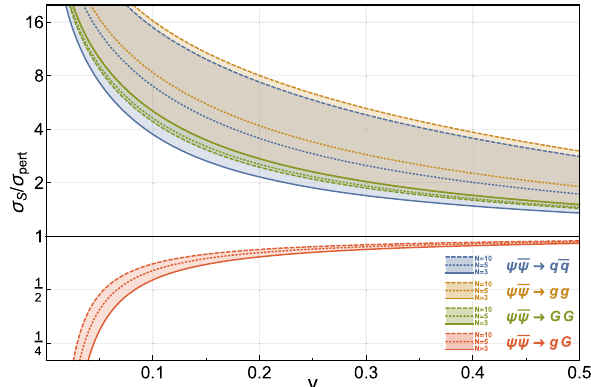
Fig. 5 Sommerfeld-correction factors for the s -wave annihilation cross sections of fermionic messengers in the fundamental represen- tation of both QCD and SU ( N ) . The different colors show the relevant annihilation processes and the different lines represent N = 3 ( solid ), N = 5 ( dotted ) and N = 10 ( dashed